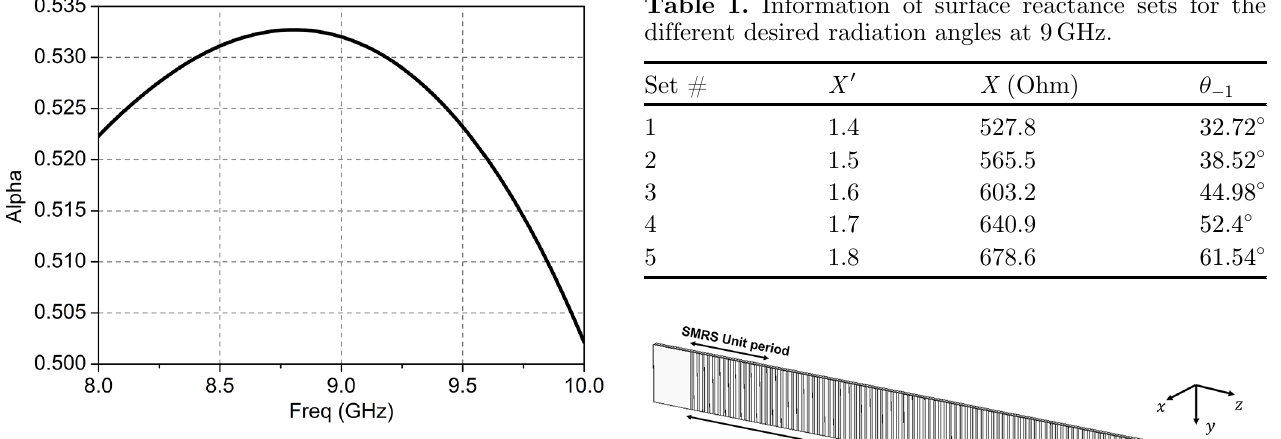
Fig. 6. Attenuation constant of the proposed antenna versus frequency based on the equation (18) of [1] when X 0 is set to 1.6. Table 2. Required surface reactances and loading capacitances at each unit cell according to the set number from Table